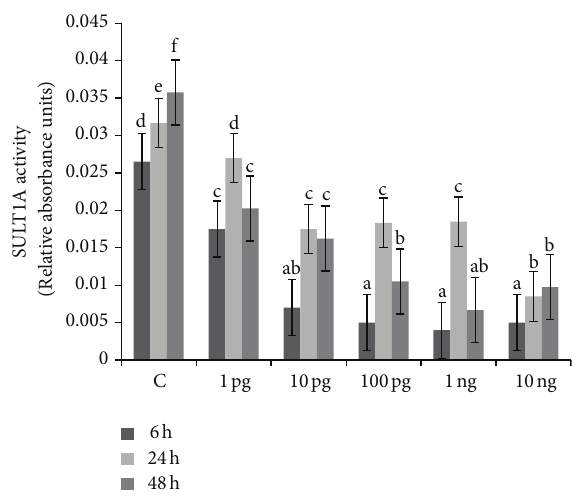
Figure 5: Time- and dose-dependent action of Halowax 1051 on SULT1A activity. Cocultures of granulose and theca cells were exposed to 1, 10, and 100 pg/mL and 1 or 10ng/mL of Halowax 1051. Statistically significant differences between points in graph are indicated with different letters; the same letters indicating no significant differences, with a < b < c < d < e < f.